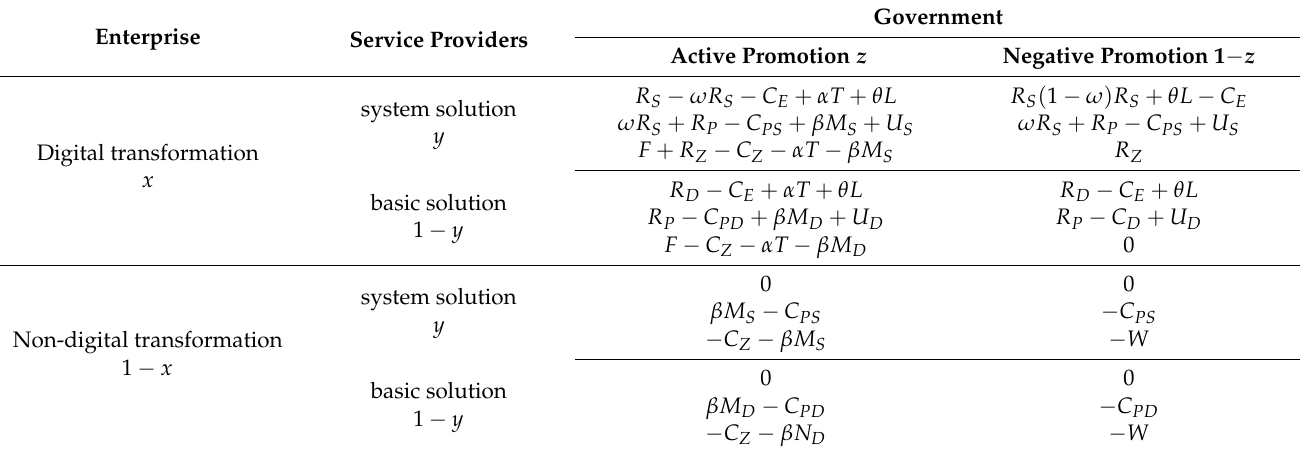
Table 2. The payment matrix for the game model including enterprise, service provider, and